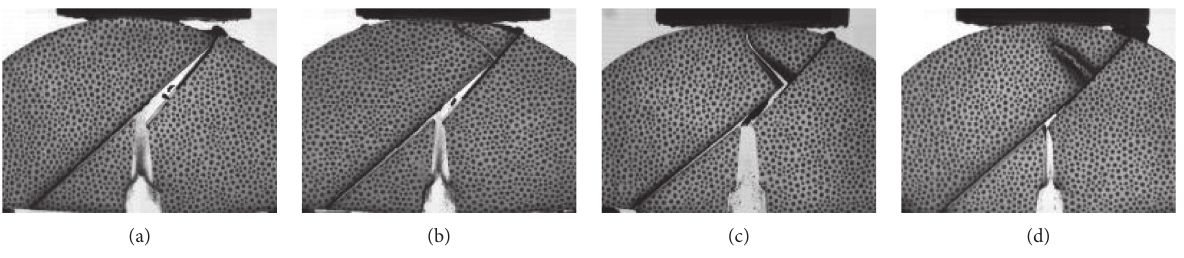
Figure 3: Different failure patterns of specimens obtained in literature [29].